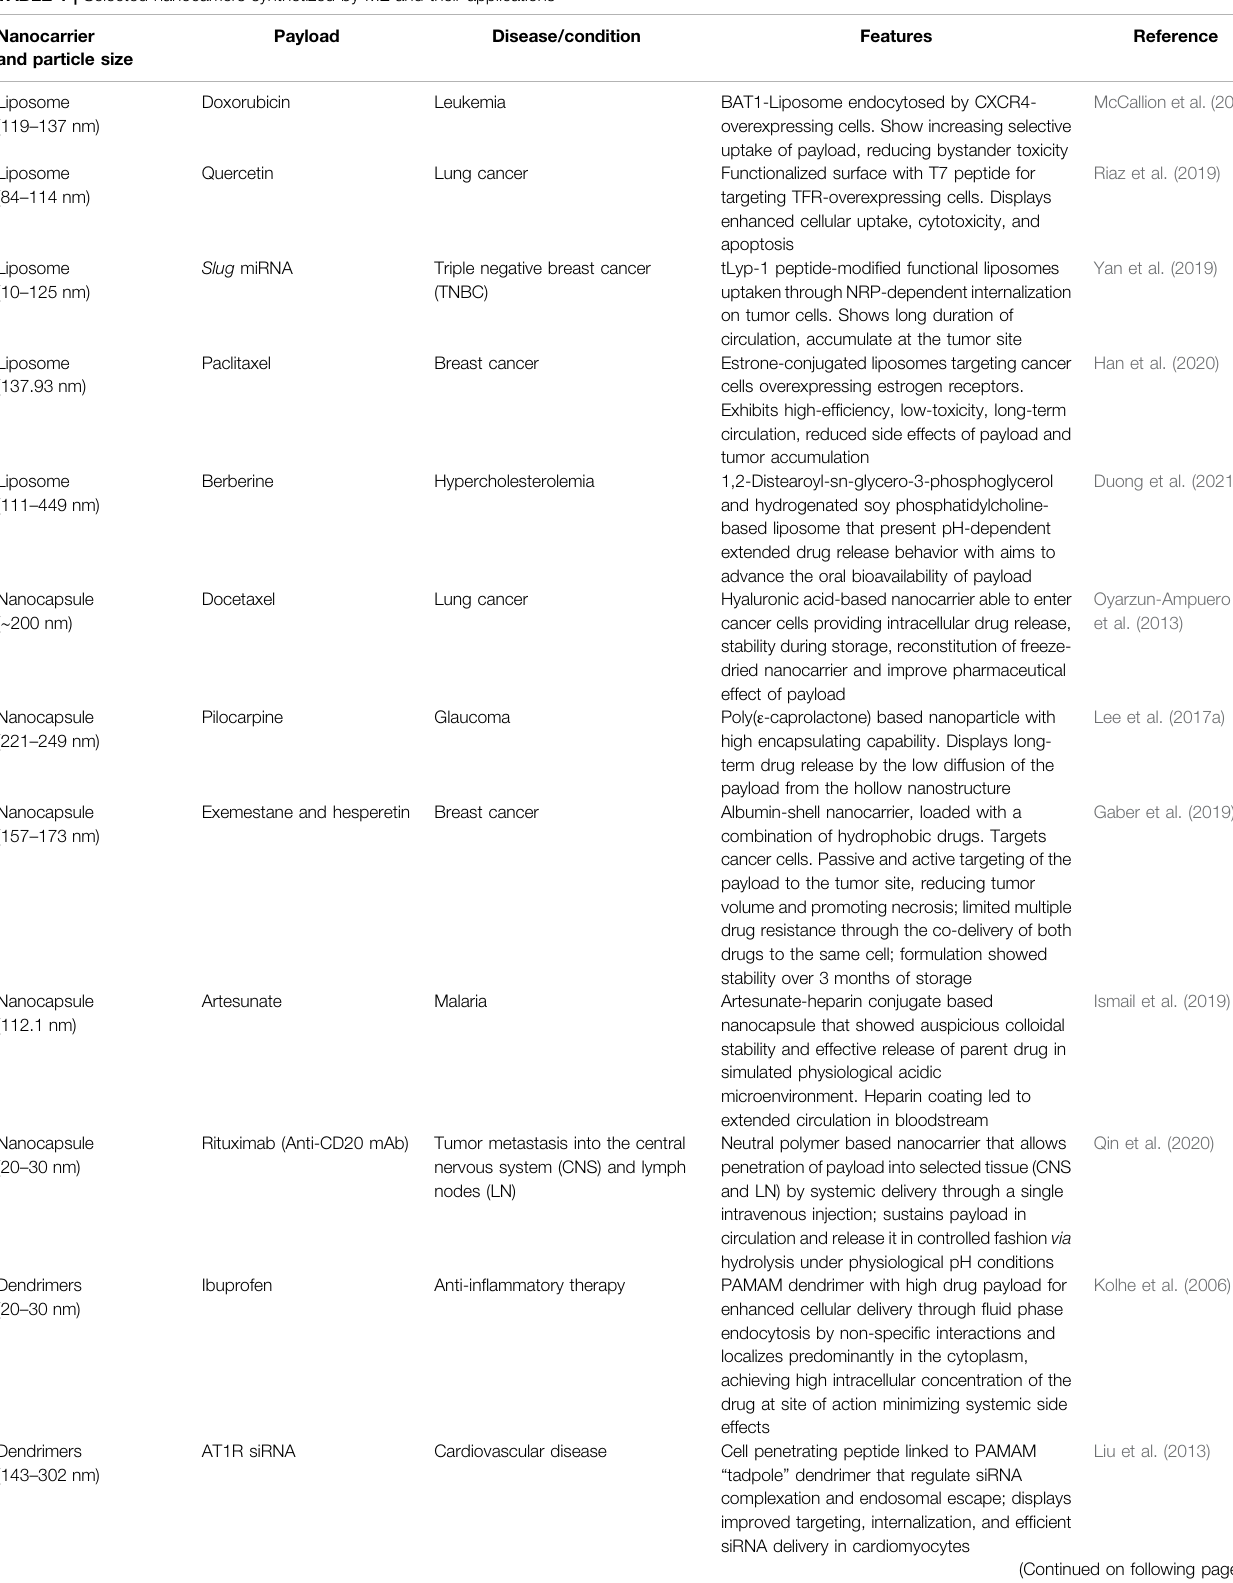
TABLE 1 | Selected nanocarriers synthetized by ME and their applications Nanocarrier and particle